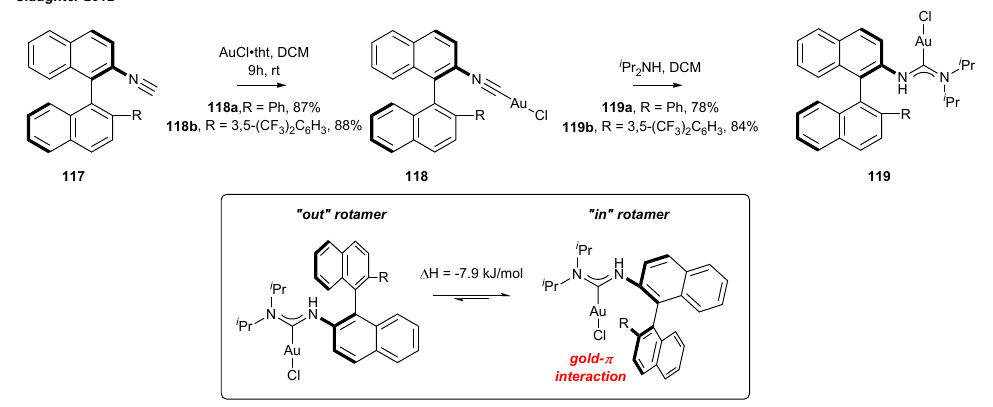
Scheme 19. The synthesis of acyclic NHC gold(I) complexes with C 1 -symmetry.